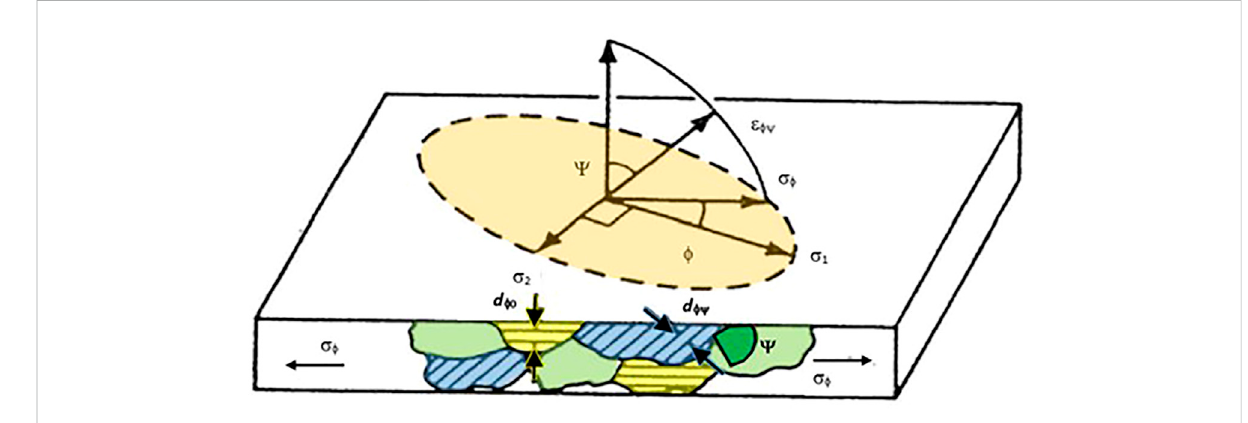
FIGURE 12 Plane-stress elastic model (adapted from Prevéy, 1986).